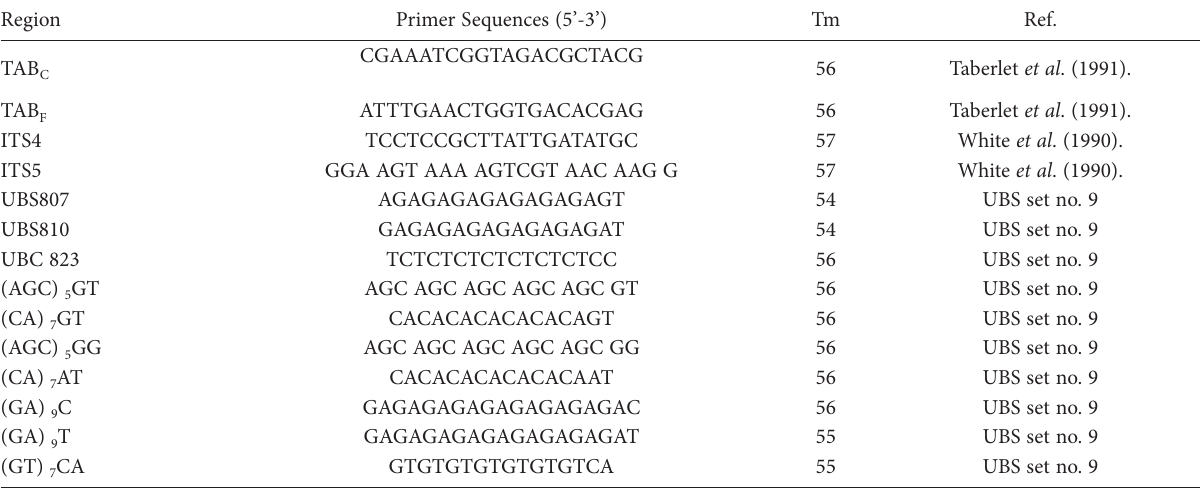
Table 2. Primer sequences used in this study. Region Primer Sequences